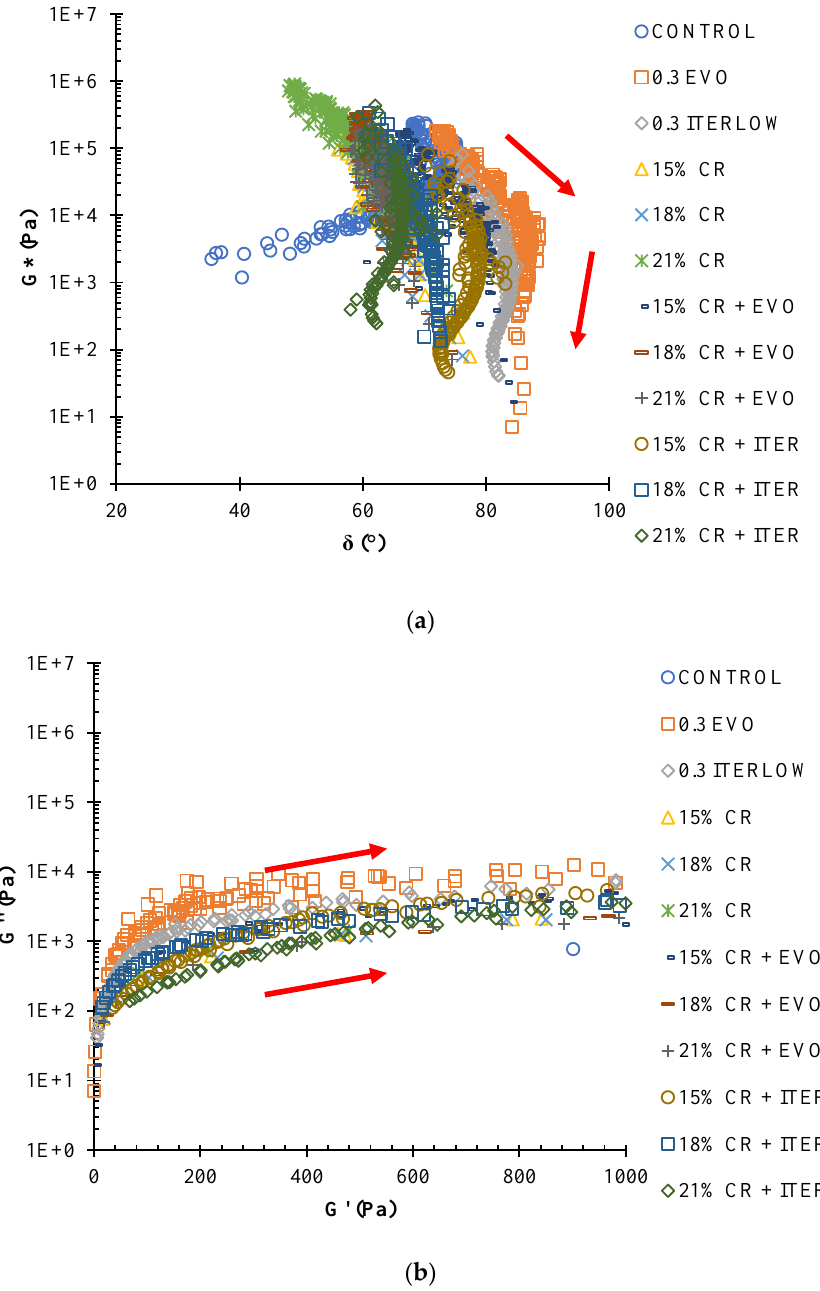
Figure 8. ( a ) Black diagram; ( b ) Cole – Cole space. Likewise, to observe more clarity in the behaviour of the rheological parameters, G * and δ were plotted versus temperature independently of the unaged and RTFO-aged samples. In Figure 9, it can be concluded that as the temperature increases, G * decreases.